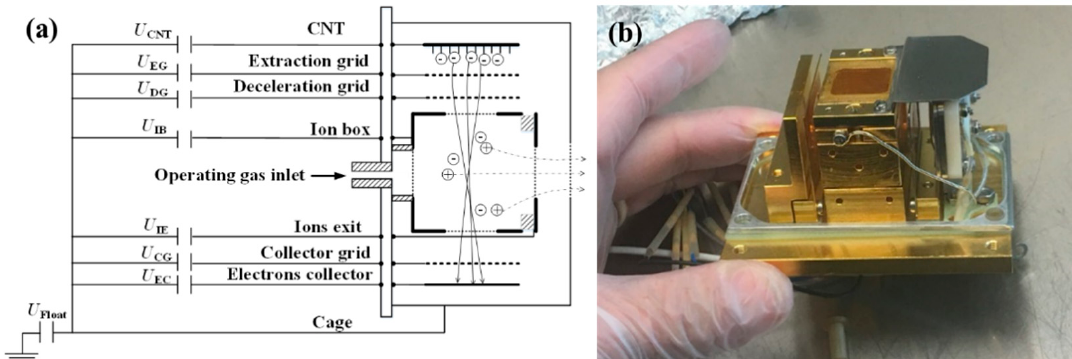
Figure 1. Schematic diagram ( a ) and photograph ( b ) of the low energy ion source with a carbon nanotube (CNT) electron emitter. The symbols ㊉ and ㊀ represent ions and electrons, respectively. The CNT-LEIS, as electron impact ion source, produces ions at a ratio between the ion current I i and the electron current I e , which was illustrated in Equation (1)